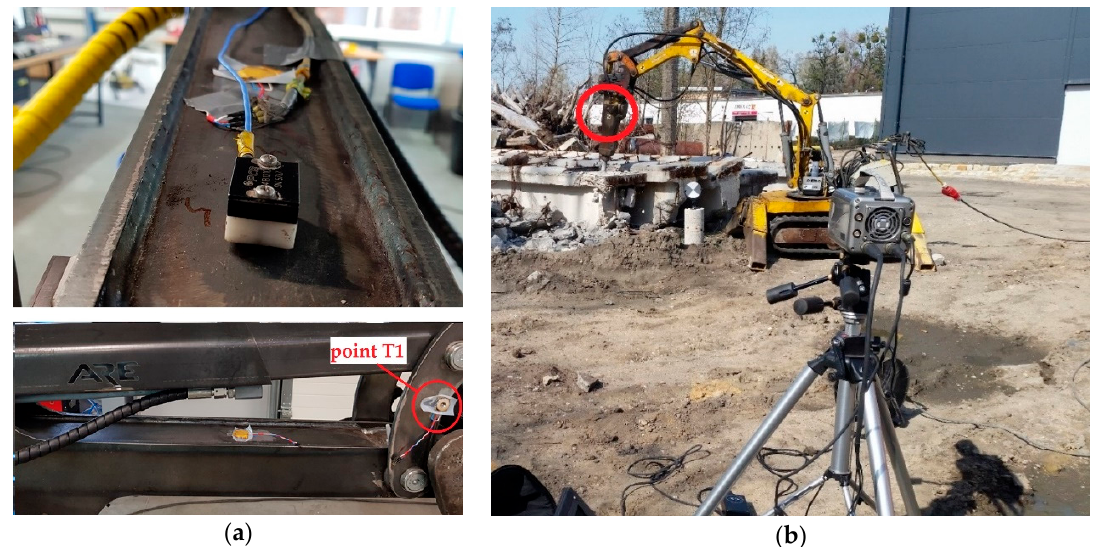
Figure 9. Experimental testing of a demolition robot with the use of: ( a ) vibration sensors positioned on the working arm of the robot depicted in Figure 8b, with an indication of measurement point T1; ( b ) high speed camera measurements (with an indication of the measurement point located on the hammer).